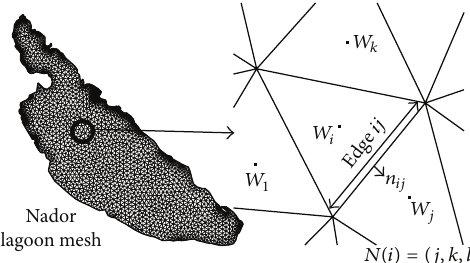
Figure 2: Nador lagoon mesh used in computational model and schematization of an example cell-centered finite